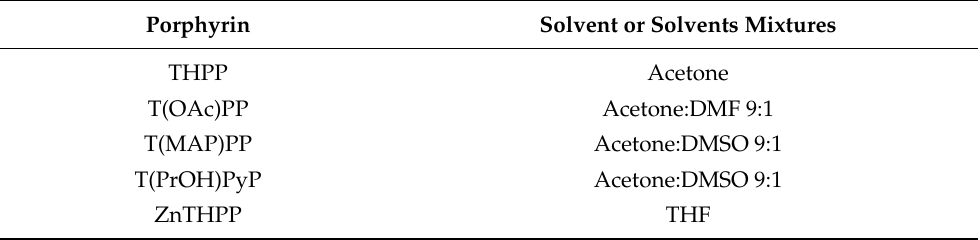
Table 7. Solvents used for the starting solution of each type of nanoparticle analyzed in the present work. Porphyrin